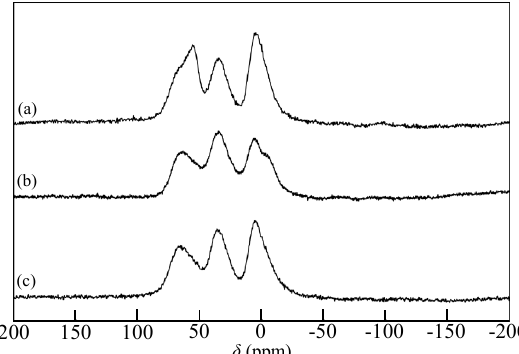
Fig. 8 Solid-state 27 Al MAS NMR spectra of the hollow silica–alumina composite spheres prepared using (a) 40, (b) 80, and (c) 120 g of the PS